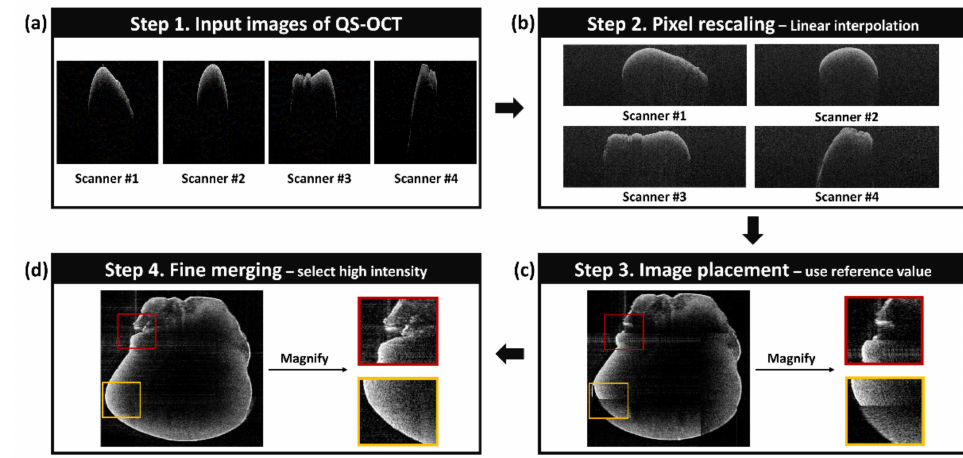
Figure 3. The description and flow chart of the image processing algorithm for obtaining the whole- directional volumetric data of the sample. ( a – d ) demonstrate each step of customized algorithm for merging cross-sectional OCT images obtained from quad-scanner